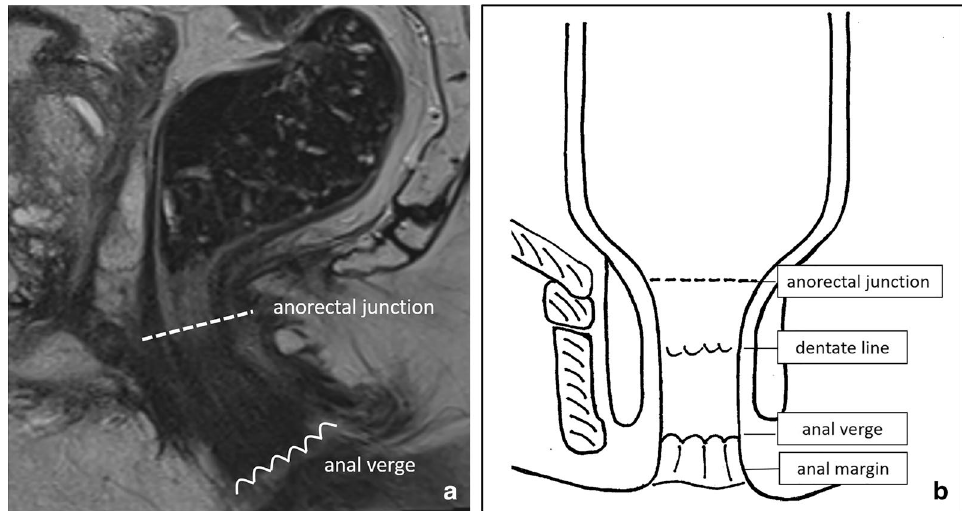
Fig. 4 Sagittal T2‑weighted MR image ( a ) demonstrating the normal anatomy of the anorectal junction (see also Fig. 2a) and the anal verge in a male individual without rectal cancer. Schematic coronal drawing ( b ) showing the anorectal junction and anal verge in relation to the dentate line (watershed junction between splanchnic and somatic innervation of the anorectum) and the anal margin, which are typically not very well appreciated on